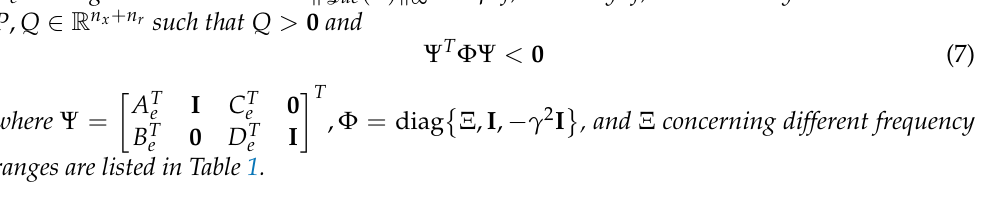
Table 1. Ξ with respect to different frequency ranges ( ω c = ω 1 + ω 2